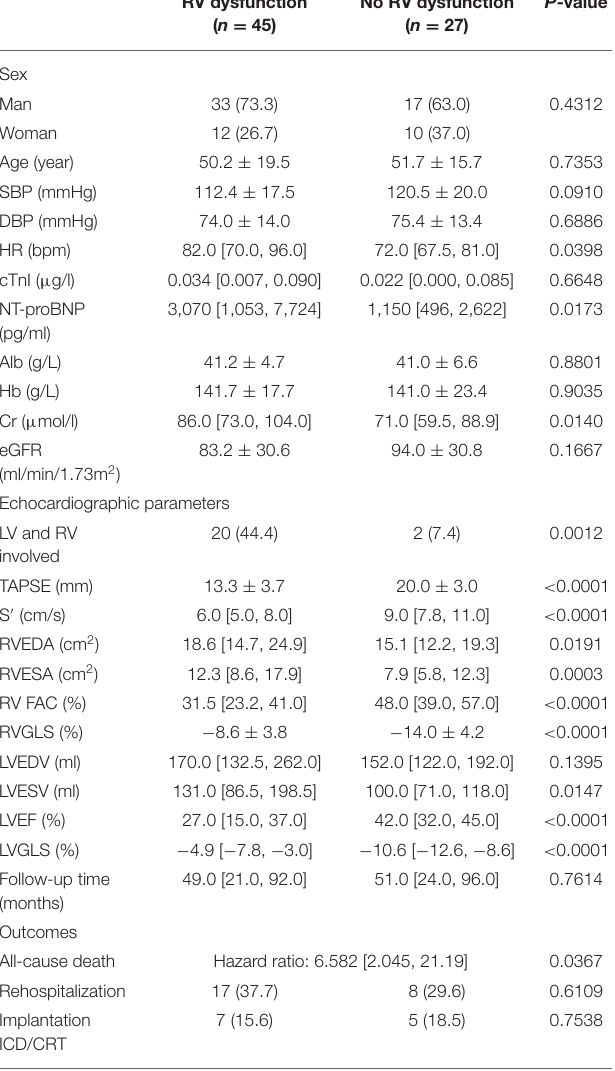
TABLE 2 | Characteristics and outcomes of patients with LVEF < 50%. TABLE 3 | Baseline characteristics of patients reaching the primary endpoint and